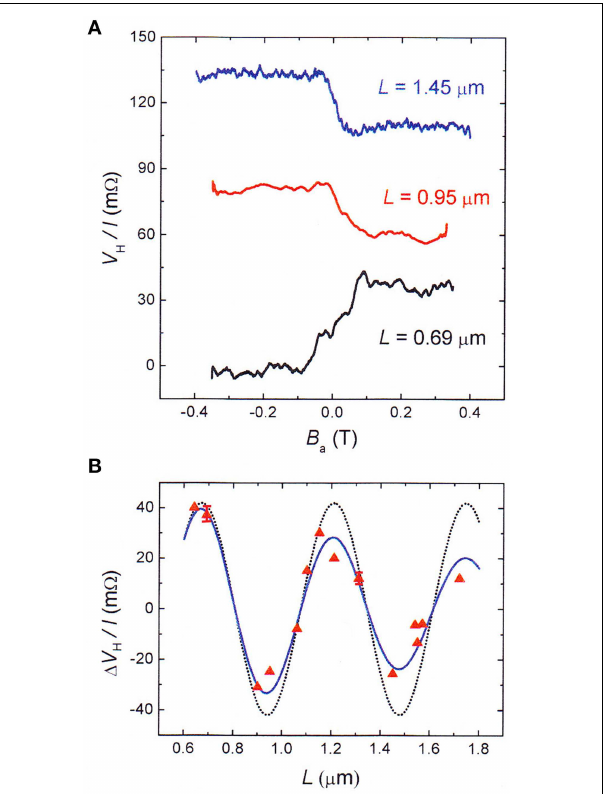
FIGURE 10 | Dependence of the inverse spin Hall voltage on channel length. (A) “Examples of inverse spin Hall voltages for several lengths L . Data are offset for clarity. Baseline (offset) resistances R B are 170 m (cid:127) , 360 m (cid:127) , and 2.4 (cid:127) for L = 0.69, 0.95, and 1.45 µ m, respectively. The value R B 2 . 4 (cid:127) is = much larger than 1 R H ( L 23 m (cid:127) , but less than 3% of the 1 . 45 µ m ) = = channel resistance. (B) 1 R H as a function of channel length L . w C 0 . 75 µ m, = I 0 . 1 mA, T 1 . 8 K. Dotted line fit is from the ballistic transport model, = = Equation (3). Solid line fit is the same model modified to include the exponential decay of ballistic trajectories. Error bars are smaller than symbols except where shown.” Figure and portion of caption reproduced from Choi et al.